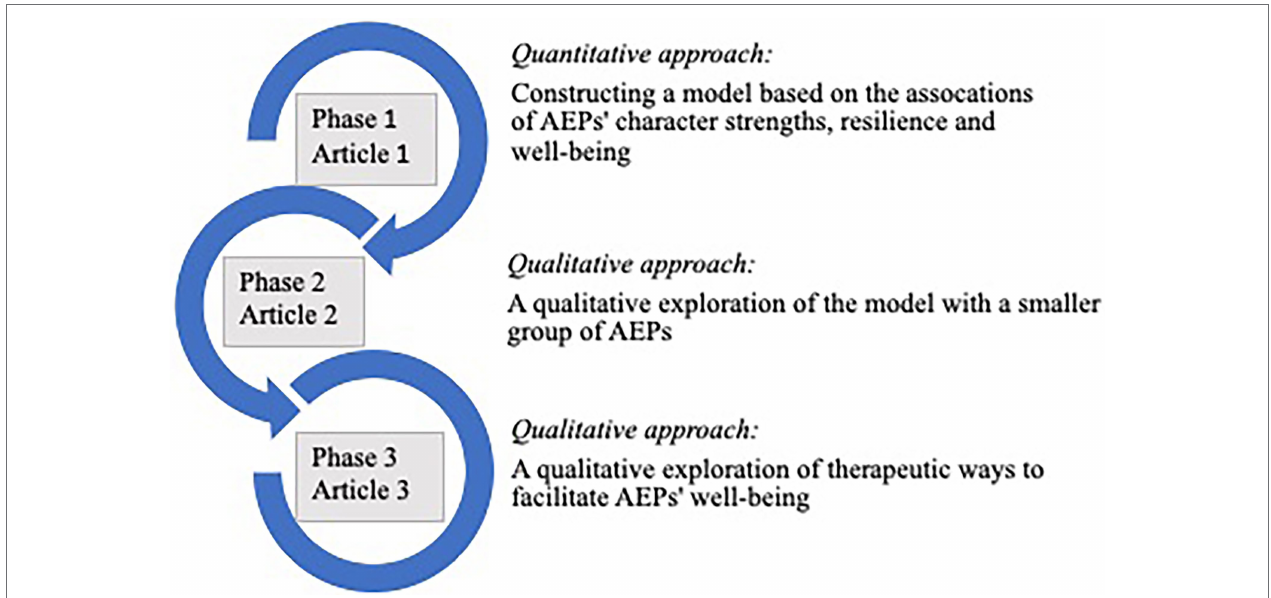
FIGURE 1 | A graphical illustration of the multimethod research approach.